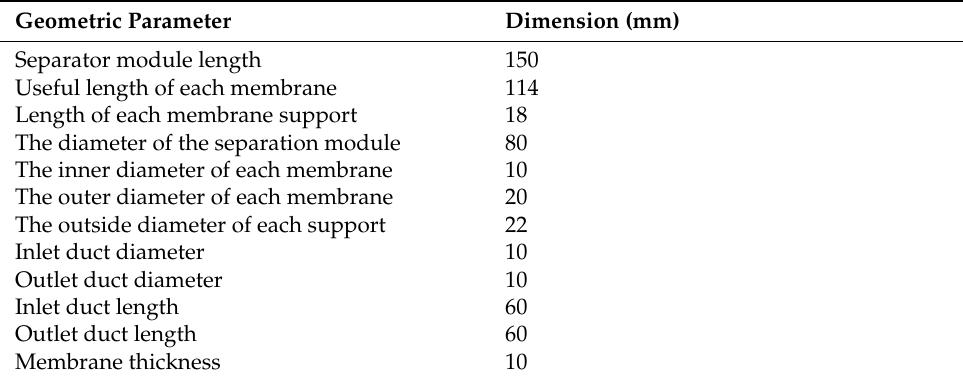
Table 1. Geometric dimensions of the shell-tube separation